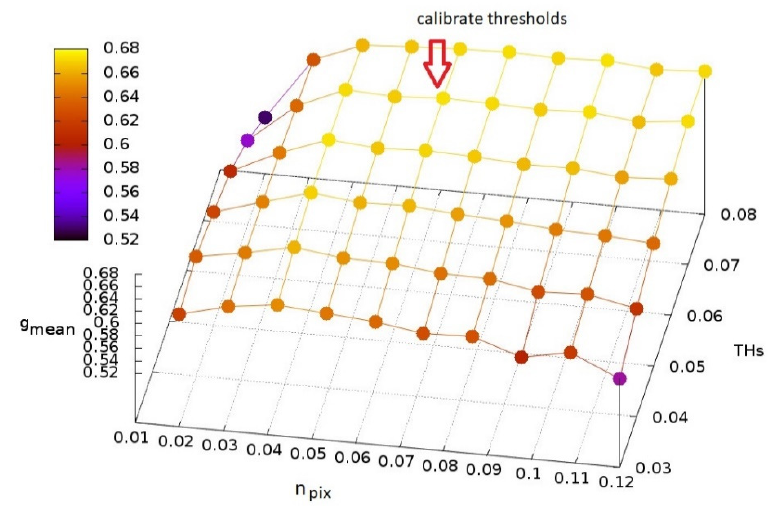
Figure 3. Calibration of TTM using the calibration dataset in terms of g mean with respect to the parameters n pix and TH S . The arrow indicates the parameter combination that produced the greatest accuracy.